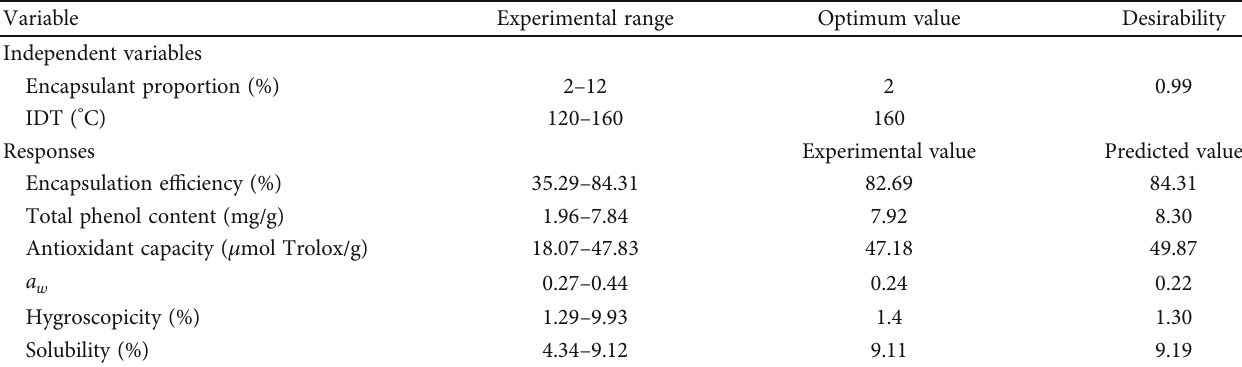
Table 5: Optimum parameters of response variables obtained using the desirability function for atomised extracts. Variable